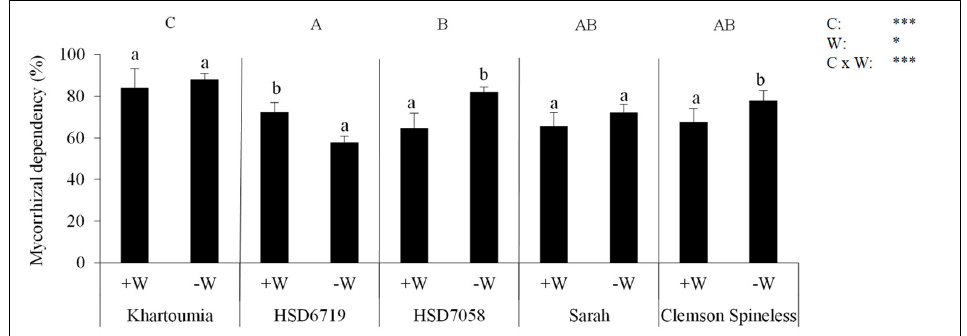
Figure 7. Mycorrhizal dependency in percent calculated for the five okra cultivars. The mycorrhizal dependency was calculated within each treatment (C × W) by using the individual values of the total dry biomass of +M plants and mean values of the total dry biomass of −M plants. It was calculated according to the formula: %MD = (total DW (mycorrhizal plant) – mean total DW (non-mycorrhizal plants))/ (mean total DW (non-mycorrhizal plants)) × 100. For definitions of treatments and statistics, refer to the text for Figure 2.